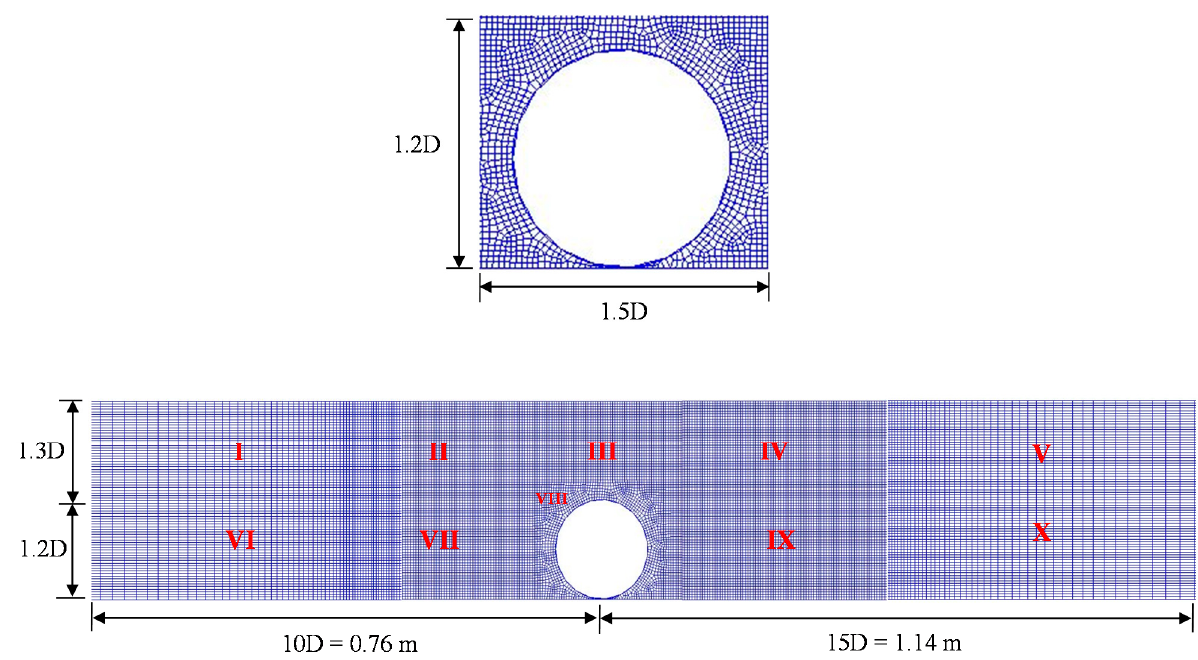
Figure 3. Computational domain and grid arrangement for the circular dam (D is the diameter of the dam).